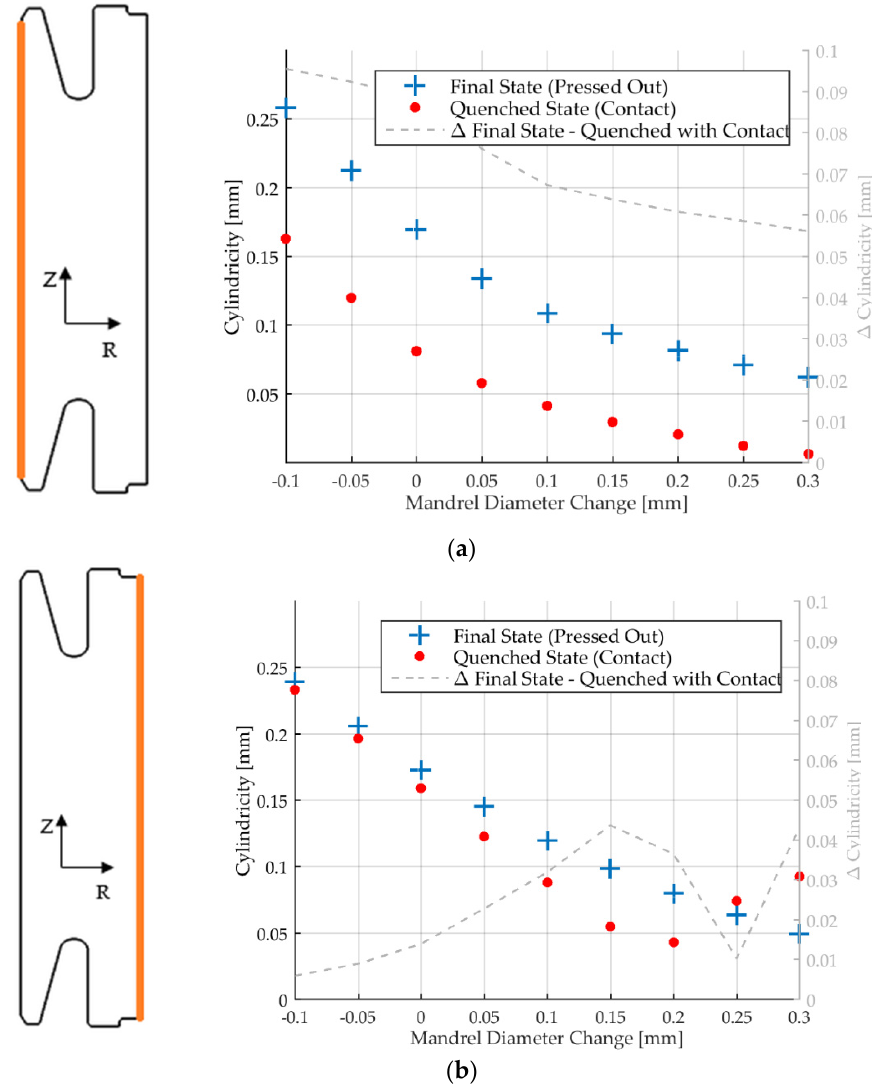
Figure 16. Model prediction of cylindricity in quenched and final states and difference between the two states. ( a ) Inner radius. ( b ) Outer radius.